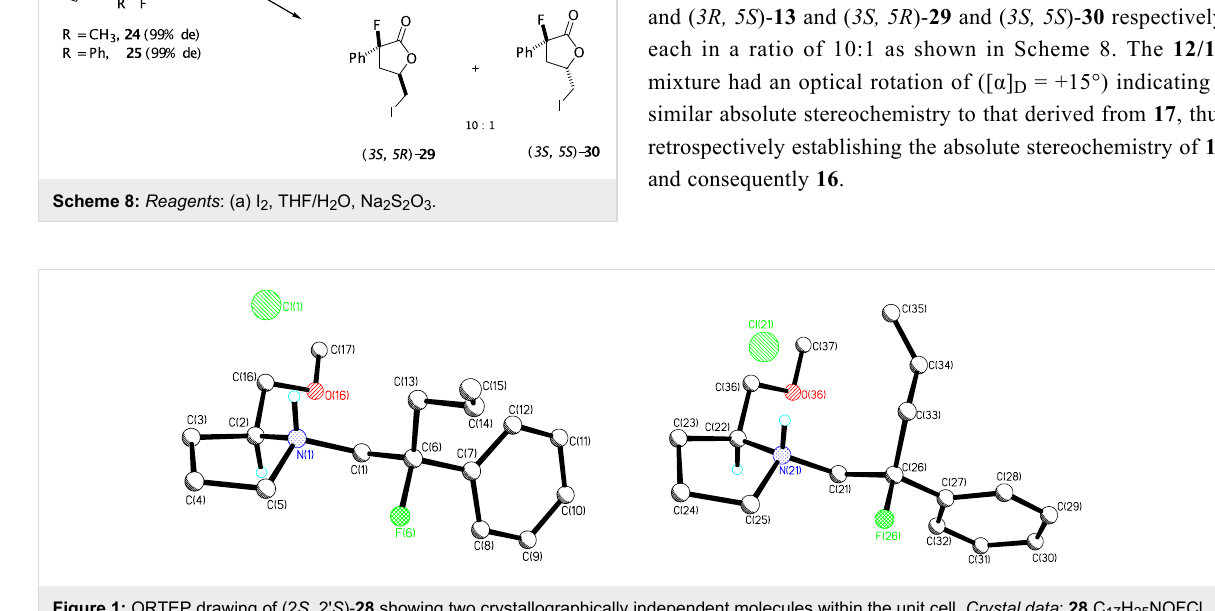
Figure 1: ORTEP drawing of (2 S , 2' S )- 28 showing two crystallographically independent molecules within the unit cell. Crystal data : 28 C 17 H 25 NOFCl, M = 313.83, monoclinic, space group P 2 1 , a = 7.0446(8), b = 23.709(4), c = 9.8268(16) Å, β = 92.554(4)°, U = 1639.6(4) Å 3 , F(000) = 672, Z = 4 [two crystallographically independent molecules], D c = 1.271 Mg m -3 , μ = 0.242 mm -1 , 4572 unique data ( R merg = 0.0194). Conventional R = 0.0256 for 4485 reflections with I ≥ 2σ, GOF = 1.032. Final wR2 = 0.0657 for all data (390 refined parameters). The largest differences in the residual maps are 0.191 and -0.201e.Å -3 . The Flack parameter refined to 0.01(3). Crystallographic data has been deposited with the Cambridge Crystallographic Data Centre as supplementary